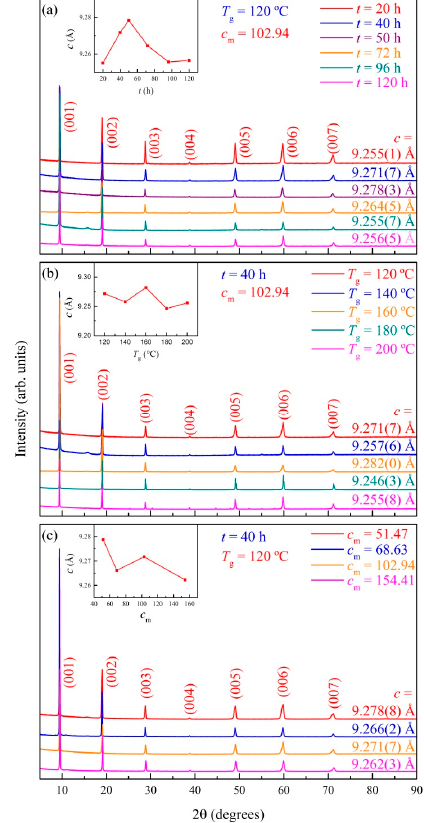
Figure 8. Dependence of the XRD patterns of the obtained (Li 1 − x Fe x )OHFeSe single crystals using the K 0.80 Fe 1.81 Se 2 precursors on ( a ) t , ( b ) T g , ( c ) c m . The insets show the effects of these three parameters on c , respectively [53]. Reprinted with permission from IOP. All rights reserved.